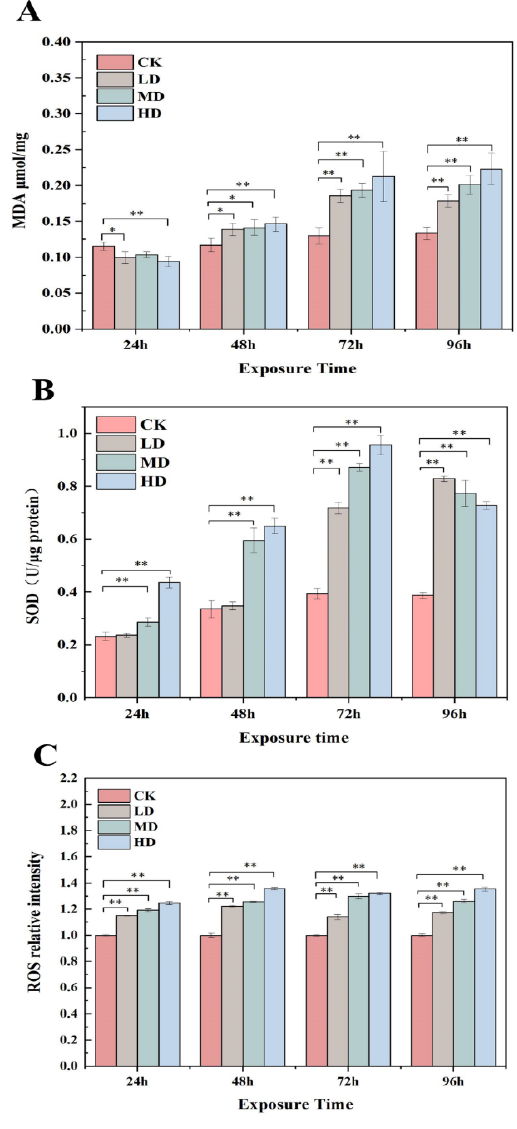
Figure 4. Effects of 17 α -EE2 concentrations on MDA content ( A ), SOD activity ( B ), and ROS activity ( C ) in C. pyrenoidosa within 96 h exposure. * and ** represent statistically significant differences with respect to the values of control cultures at p < 0.05 and at p < 0.01 levels, respectively. CK: control; LD: low dose; MD: moderate dose; HD: higher dose.